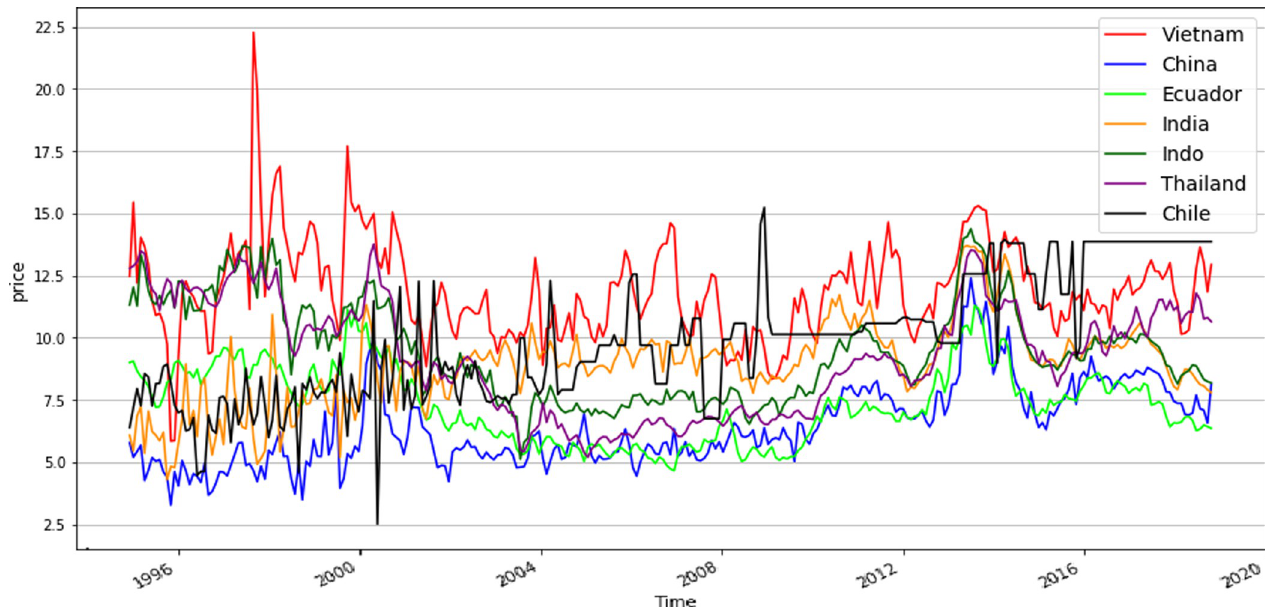
Fig 5. Comparison of prices among competitors, including